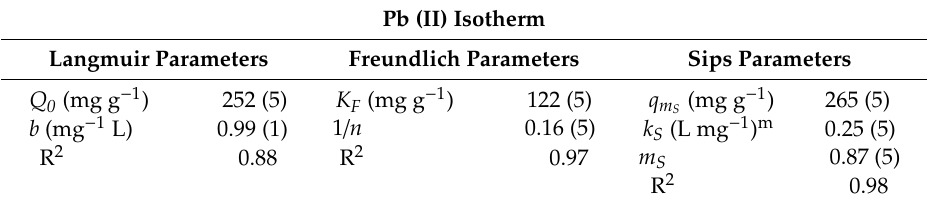
Figure 10. Pb(II) adsorption isotherm for NPZEO3 as adsorbent in Pb-contaminated water. Table 5. Parameters obtained from fitting the Langmuir, Freundlich, and Sips models to the experimental isotherm for Pb(II)